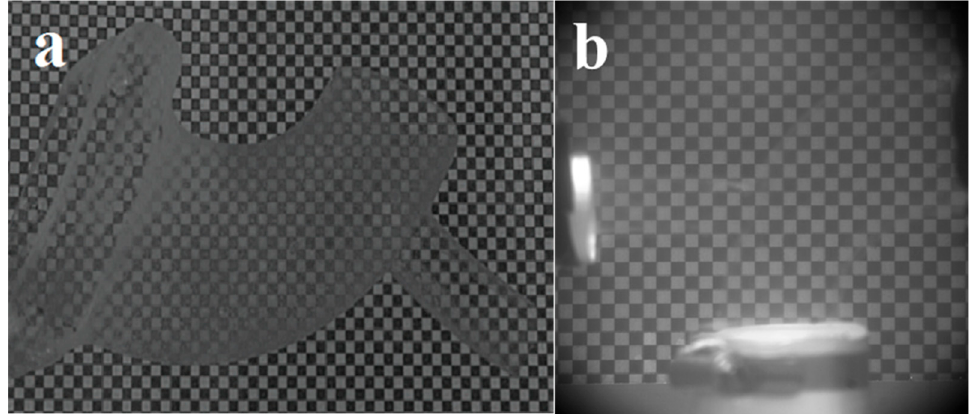
Figure 5. Silicone phantom in the refractive index matched fluid; ( a ) the initial phantom, ( b ) the second phantom. Note that neither phantom distorts the checker plate background.